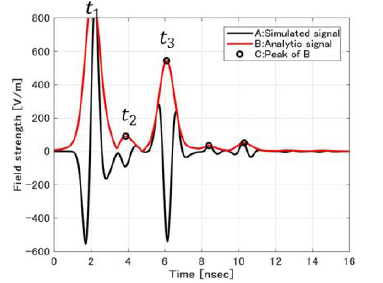
Figure 2. Reflected wave simulated by gprMax.